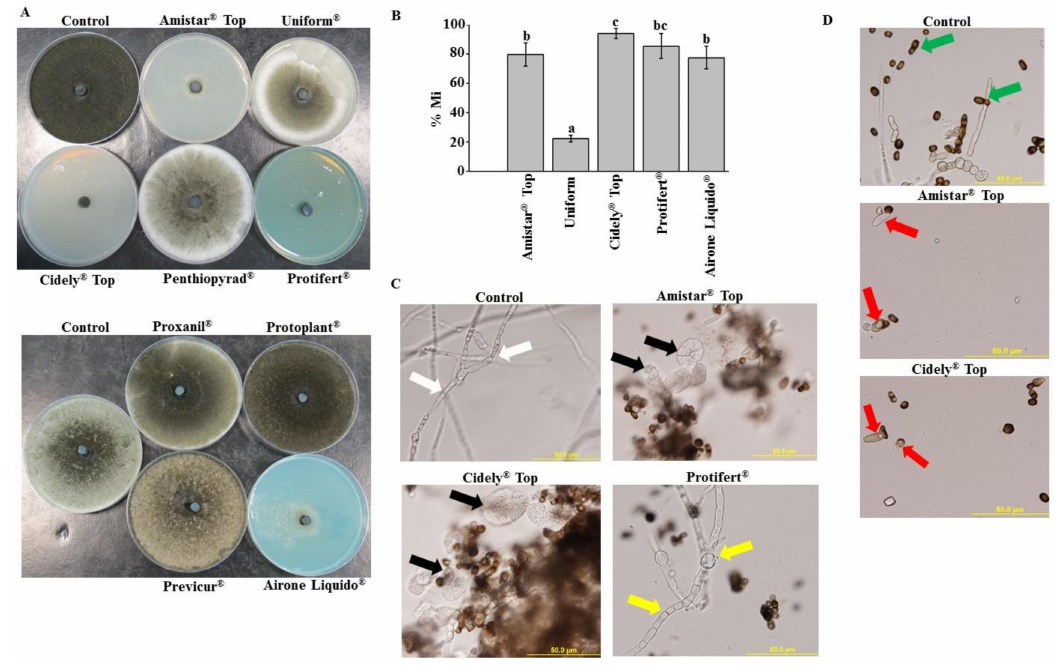
Figure 5. In vitro e ffi cacy of fungicides against Neoscytalidium dimidiatum . ( A ) E ff ect of the fungicides Amistar Top ® , Uniform ® , Cidely ® Top, Penthiopyrad ® , Protifert ® (top panel), Proxanil ® , Proplant ® , Previcur ® and Airone Liquido ® (bottom panel) at the concentration of 250 ppm on in vitro mycelial growth; and ( B ) growth inhibition rate (% Mi) of N. dimidiatum using 250 ppm of the fungicides after 5 days. ( C ) Abnormalities in hyphal morphology, septum formation and cytoplasmic contents; and ( D ) deformation of conidia of N. dimidiatum following Amistar Top ® and Cidely ® Top treatments compared to control. In ( B ) , values with di ff erent letters are significantly di ff erent from each other at p < 0.05; In ( C ) , white arrows indicate normal septate hyphal growth; black arrows indicate formation of non-septate hyphal formation and cytoplasmic coagulation; yellow arrows indicate lysis of hyphal wall and cytoplasm leakage. In ( D ), green arrows indicate normal formation of conidia and arthroconidia segmenting from hyphae; and red arrows indicate deformation of conidia and absence of